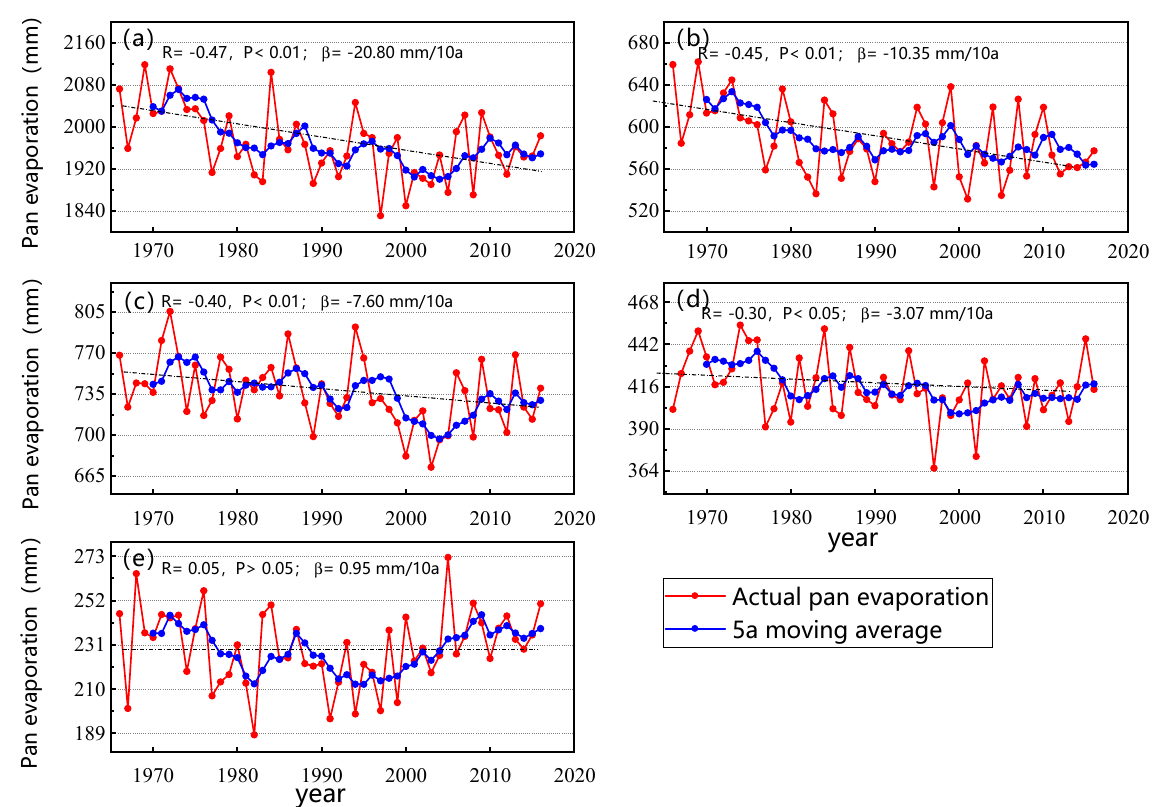
Figure 6. Variation of Epan on the TP on different timescales in 1966–2016. ( a ) Annual, ( b ) spring, ( c ) summer, ( d ) autumn, ( e ) winter. Epan in the TP region also reported significant seasonal variations. Overall, the mean Epan in summer was the largest of the annual total with 37%, followed by spring (30%), autumn (21%), and winter (12%). Consistent with the annual variation, the spring and summer mean Epan demonstrated a significant declining trend at the 95% confidence level with rates of − 10.35 mm/10a and − 7.6 mm/10a, respectively, while the variation trend of the mean Epan in autumn ( β = − 3.06 mm/10a) was not statistically significant ( α = 95%).